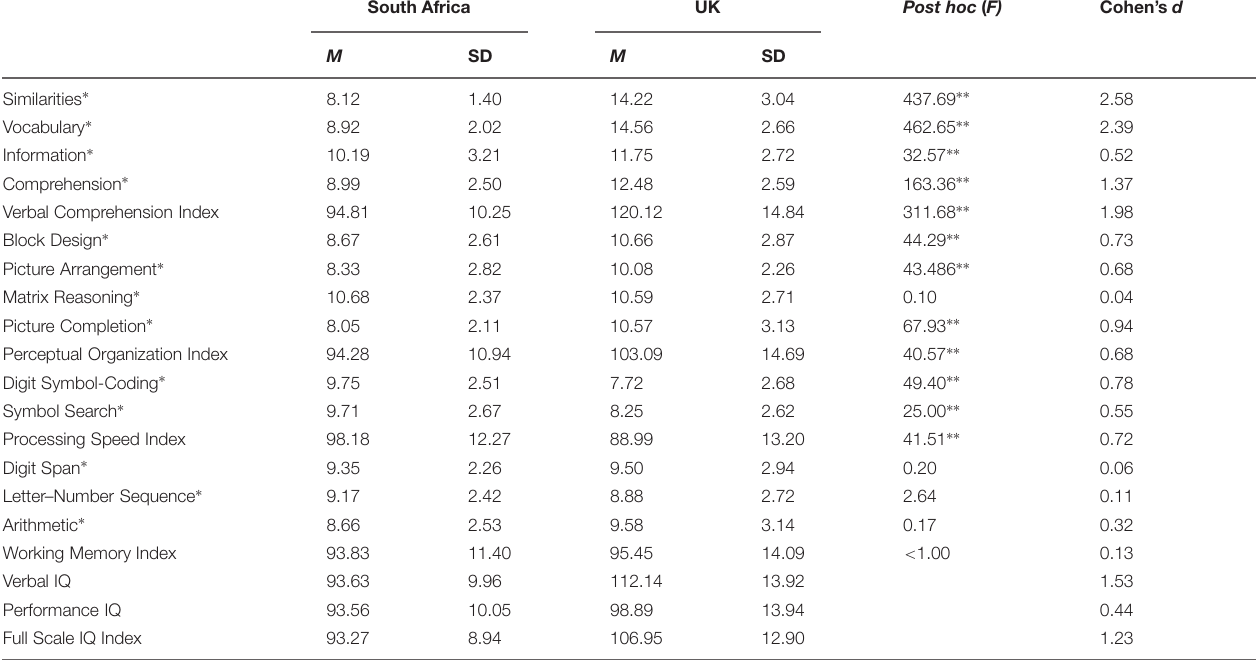
TABLE 1 | Descriptive statistics of scores for all IQ subtests (standard scores unless otherwise